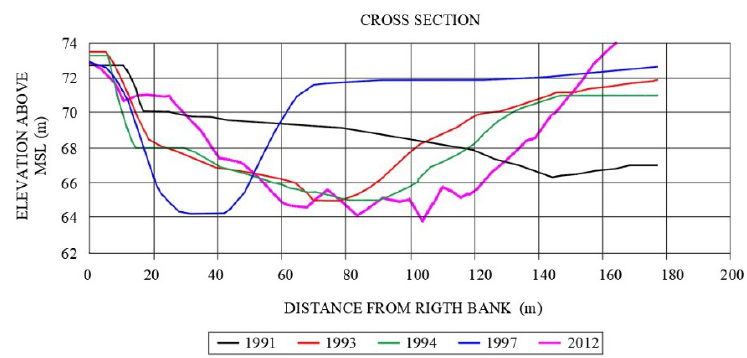
Figure 5. E ff ect of the submerged vane field installed in front of ECOPETROL’s Aromatics pier in 1993 Figure 5. Effect of the submerged vane field installed in front of ECOPETROL's Aromatics pier in 1993 over over time.